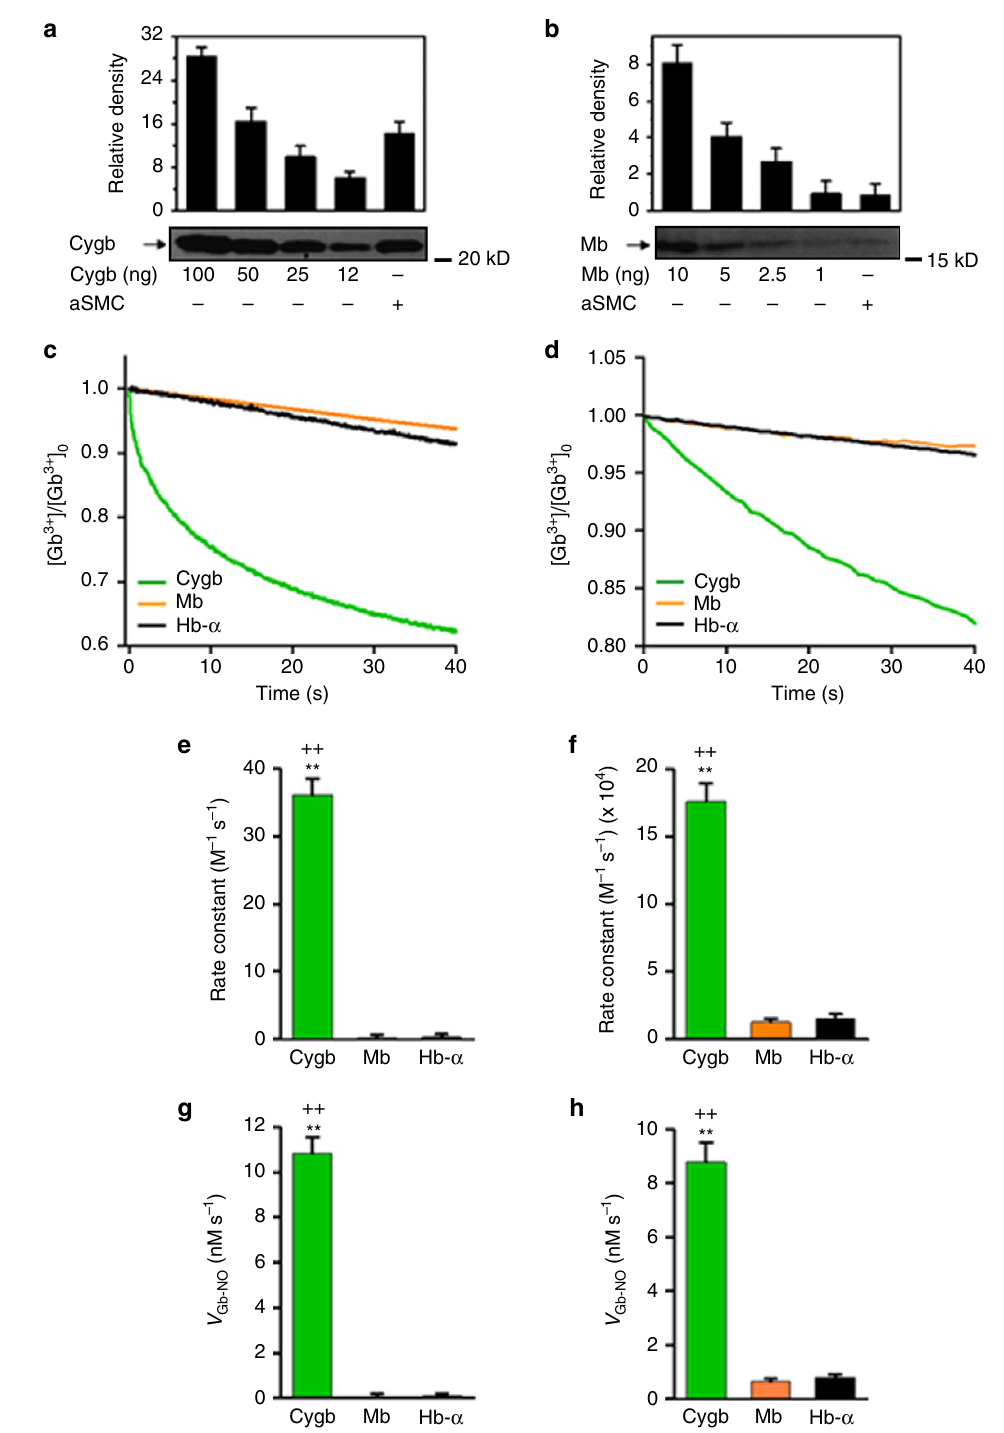
Figure 1 | Expression of globin proteins, reduction rates and rates of NO consumption of Cygb, Mb and Hb- a . Level of Cygb ( a ) and Mb ( b ) in human aortic smooth muscle cells (aSMCs) measured by quantitative immunoblotting. These results indicate that there is B 45ng of Cygb and B 1ng of Mb in 10 6 aSMCs. Hb- a was not detectable with a level 4 200-fold below that of Cygb. Assuming a cell volume of 400 m m 3 (ref. 11), the intracellular concentration of Cygb is estimated at B 5.3 m M and that of Mb at B 0.13 m M and Hb- a o 0.03 m M. Positions of nearest molecular weight markers are shown. Reduction of globins by 10mM Asc ( c ) or b5R (30nM)/b5 (0.5 m M)/NADH (100 m M) ( d ). Measured rate constants of Cygb, Mb and Hb- a reduction by 10mM Asc ( e ). Measured rate constants of Cygb, Mb and Hb- a reduction by b5 reductase (30nM)/b5 (0.5 m M)/NADH (100 m M) ( f ). Calculated rate of NO consumption by Cygb, Mb and Hb- a in the presence of 1 m M globin and 0.3mM Asc ( g ). Calculated rate of NO consumption by Cygb, Mb and Hb- a in the presence of 1 m M globin and 50nM b5 reductase with excess b5 and NADH ( h ). The calculation was based on the equation in Supplementary Fig. 1, also for more detail see ref. 61. Error bars: mean ± s.e.m., n ¼ 3 per group; ** P o 0.01 for Cygb versus Mb, þ þ P o 0.01 for Cygb versus Hb- a ; P values determined using a two-tailed t -test.